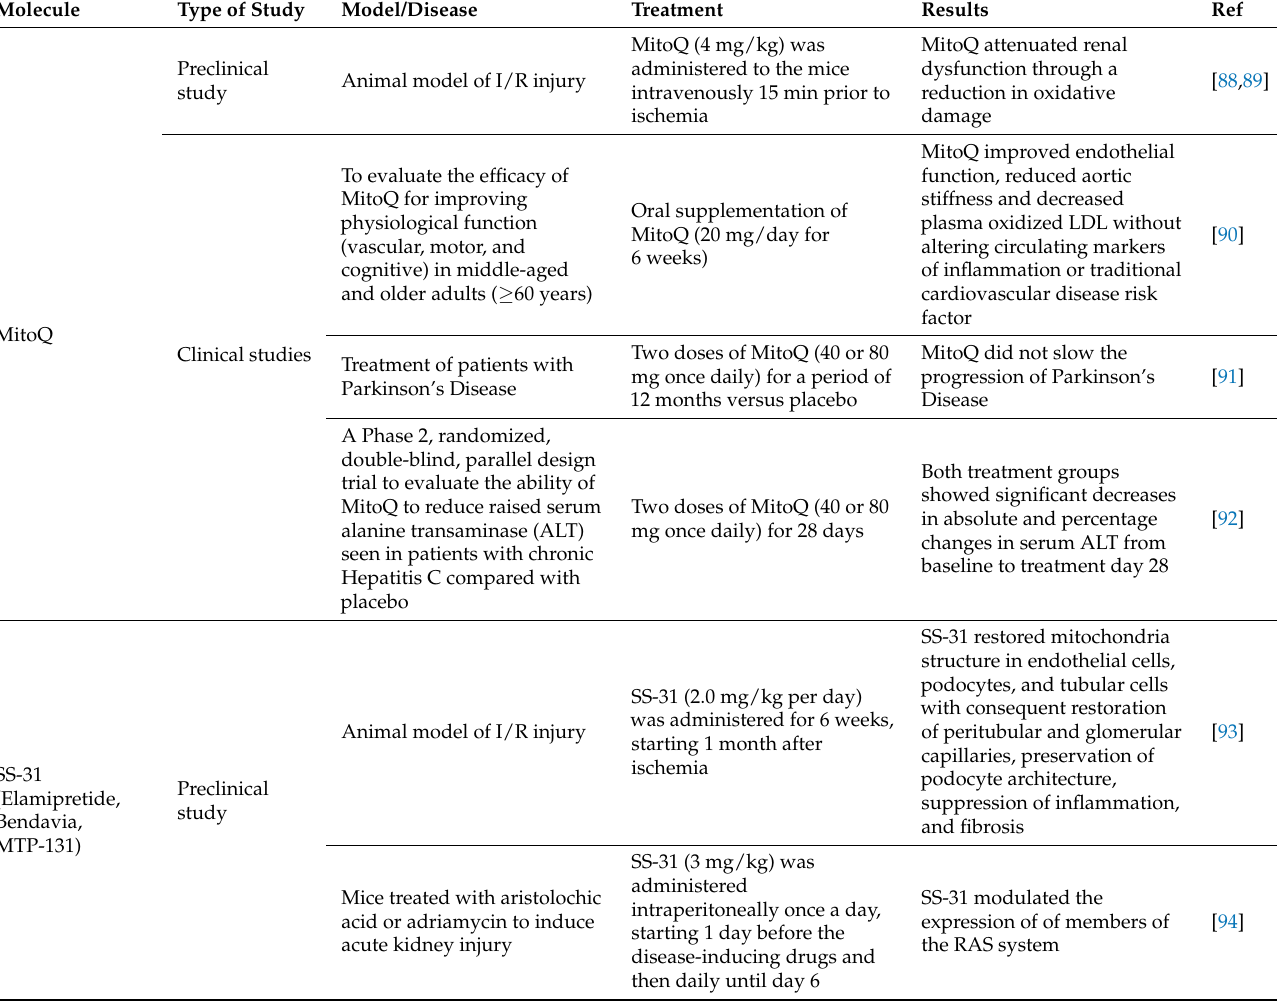
Table 3. Main published preclinical and clinical studies investigating mitochondria-targeting anti-oxidants.